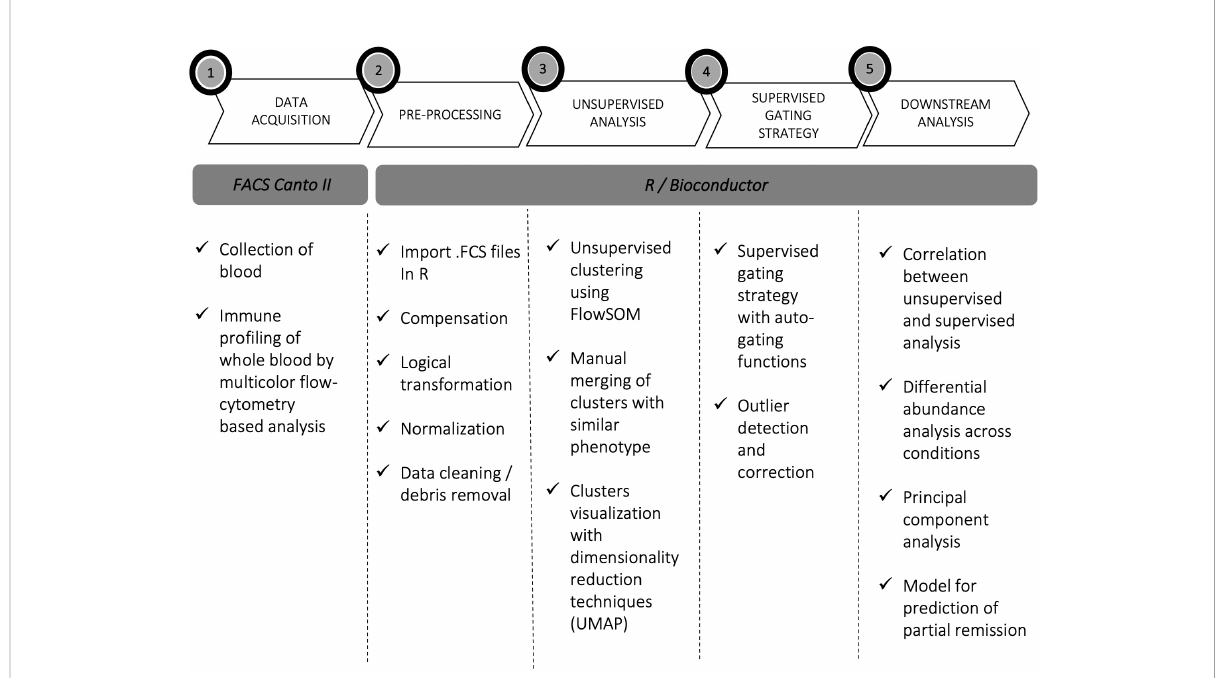
FIGURE 1 Experimental work fl ow. Experimental work fl ow of the study: acquisition (1), pre-processing (2), processing (3, 4), and downstream data analysis